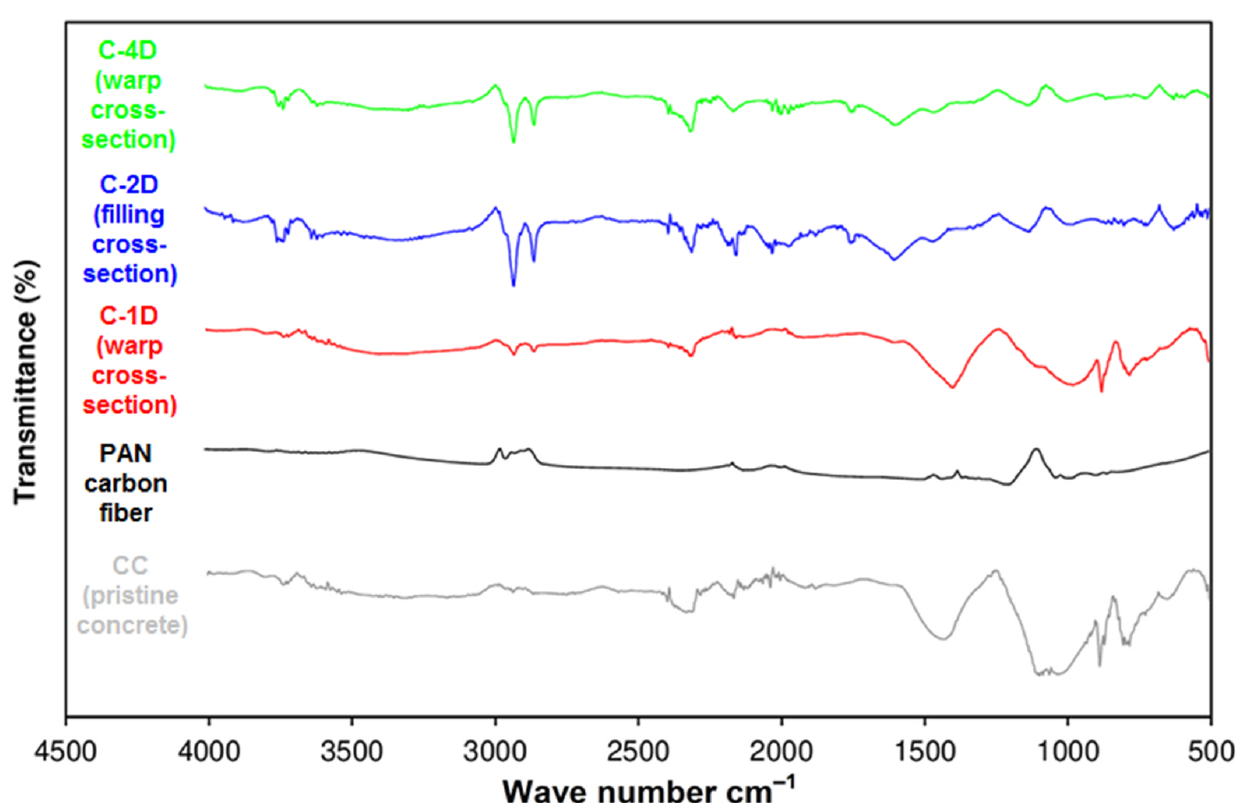
Figure 16. Fourier transform infra-red spectra of CC (pristine concrete), PAN carbon fiber, C-1D, C-2D, and C-4D carbon fiber concrete composites.